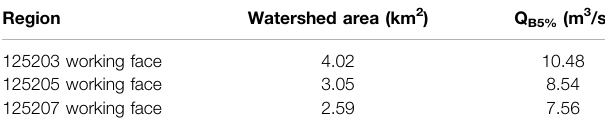
TABLE 1 | Results of gully fl ood fl ow